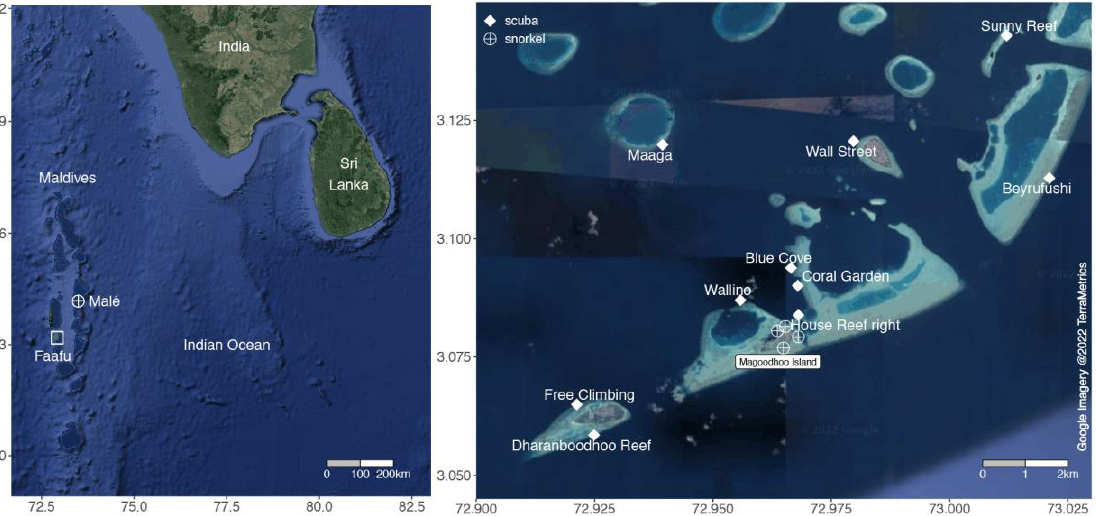
Figure 1. Maldivian Archipelago ( left ), highlighting the capital Malé (circle) and the Faafu Atoll (square), where most collecting sites are located ( right ). Scuba diving sites are labeled according to names used by staff at the MaRHE Center, based at Magoodhoo Island.